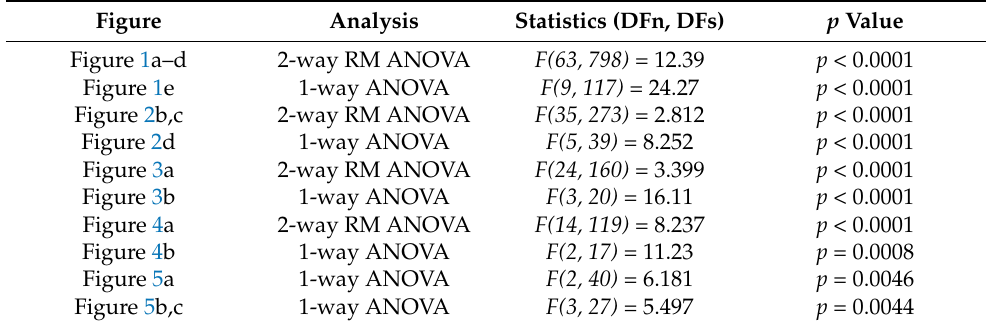
1-way ANOVA The newly synthesized inverse agonists PZ-1386 and PZ-1179 significantly reduced mTOR and S6 phosphorylation in HEK cells (Figure S1, Table S1) and, as expected,